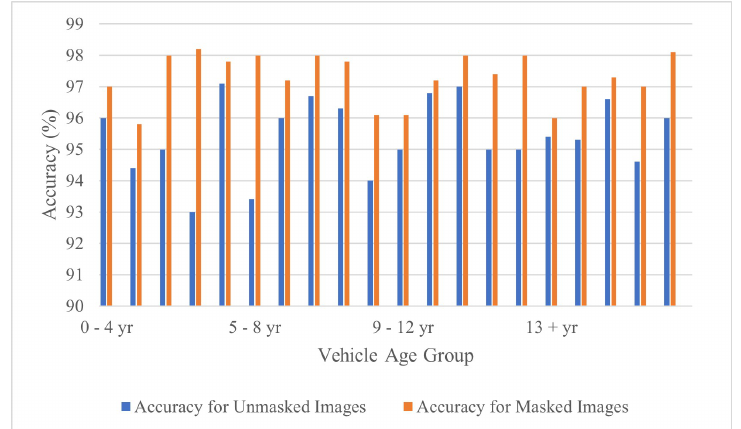
Figure 11. Accuracy tradeoff between the masked and unmasked image